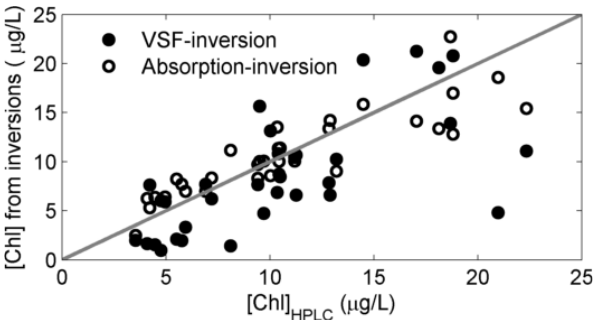
Fig. 7. Comparison of [Chl] estimated from the VSF-inversions (Eq. 2) and from the absorption spectrum inversion with the HPLC